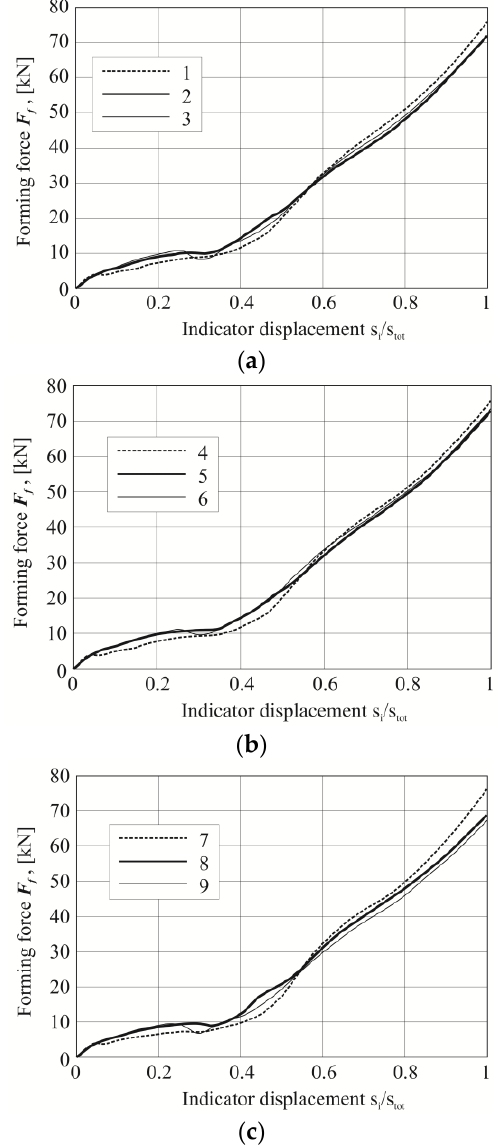
Figure 11. The forming force-displacement diagram for three group of the sheet arrangements ( a ) AW 5754-H11 and AW 6082, ( b ) AW 5754-H22 and AW 6082, ( c ) AW 5754-H24 and AW 6082.